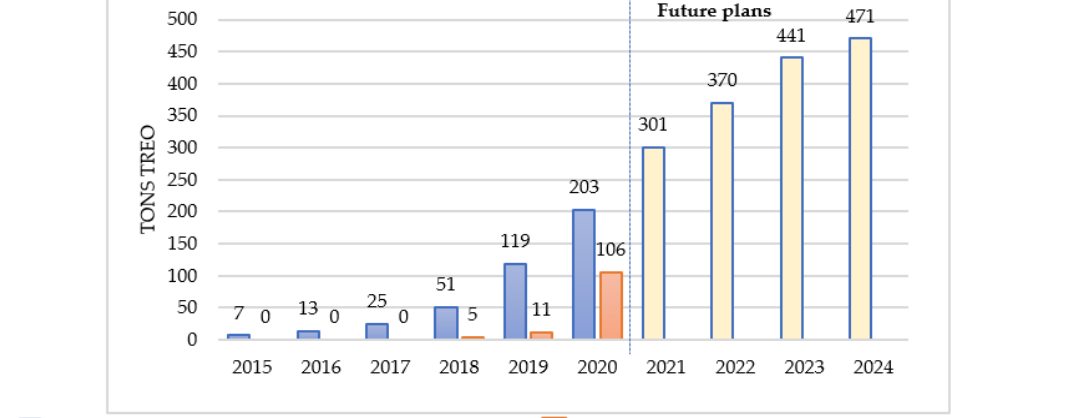
Figure 8. Total demand for key REMs (cumulative total).